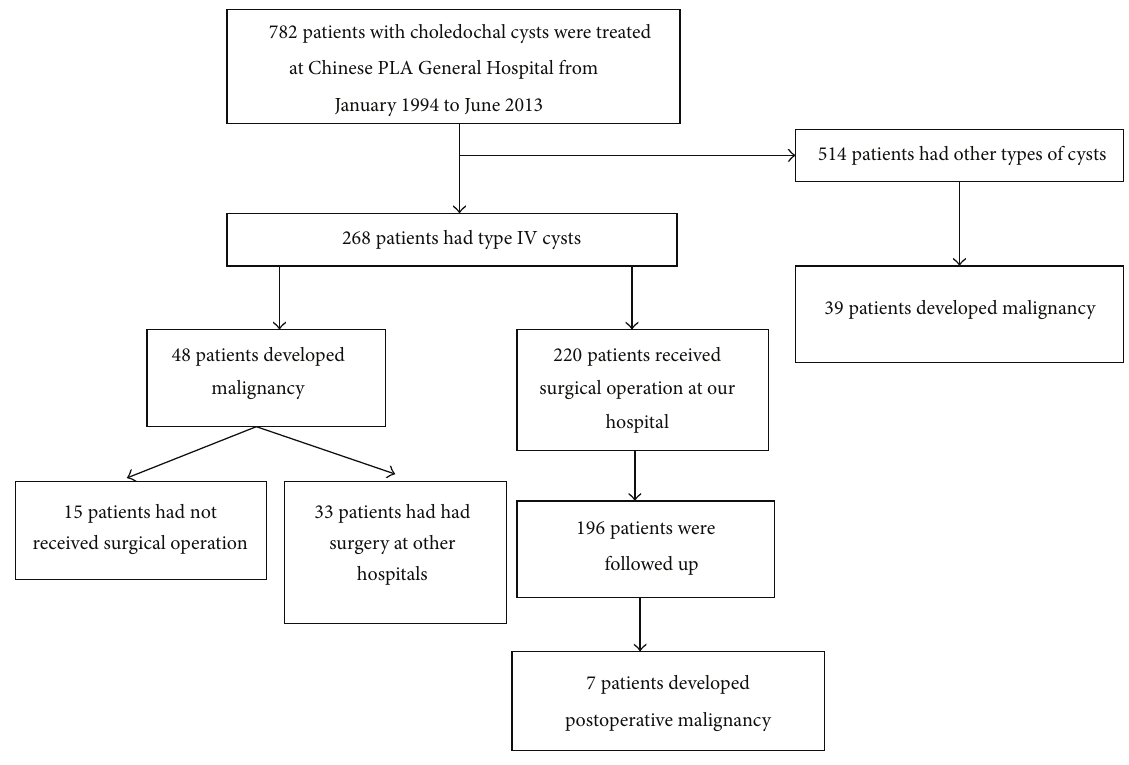
Figure 1: Flow diagram of patients’ surgeries and outcomes. PLA: People’s Liberation